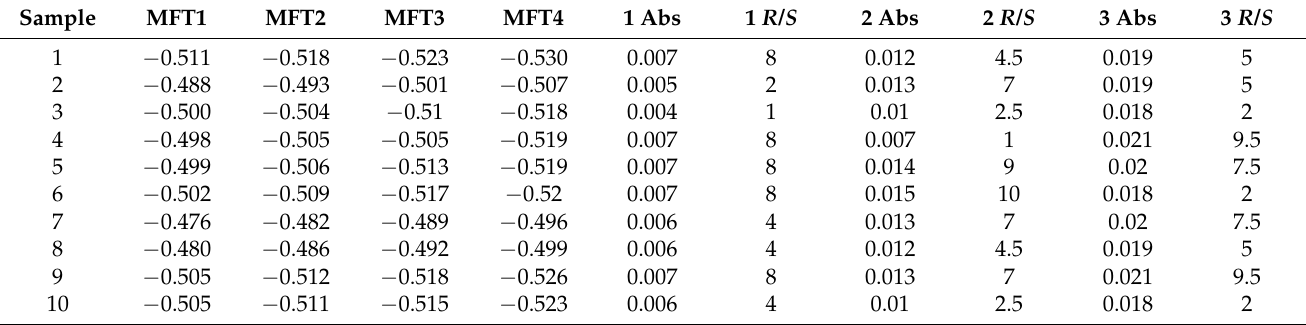
Table 3. Wilcoxon test values for two selections (MFT1, MFT2, MFT3, MFT4 = experimental variants; milk freezing temperature is in ◦ C; Abs, R and S = statistical quantities of order and pair